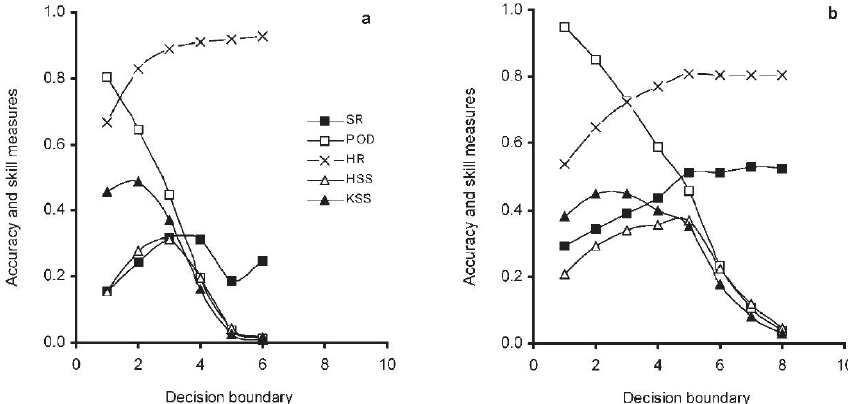
Figure 1. Dependence of accuracy and skill measures on the choice of decision boundary (number of positive neighbours of the forecast day). (a) Swiss dataset; (b) Scottish dataset. From Heierli et al. (2004) and reprinted from the Annals of Glaciology with permission of the International Glaciological Society and the lead